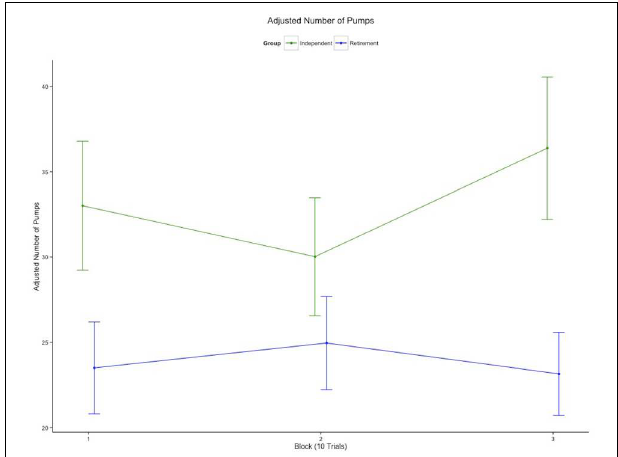
FIGURE 1 | Risk taking with experience by group. Average number of pumps per block on trials where the balloon did not explode, separated by